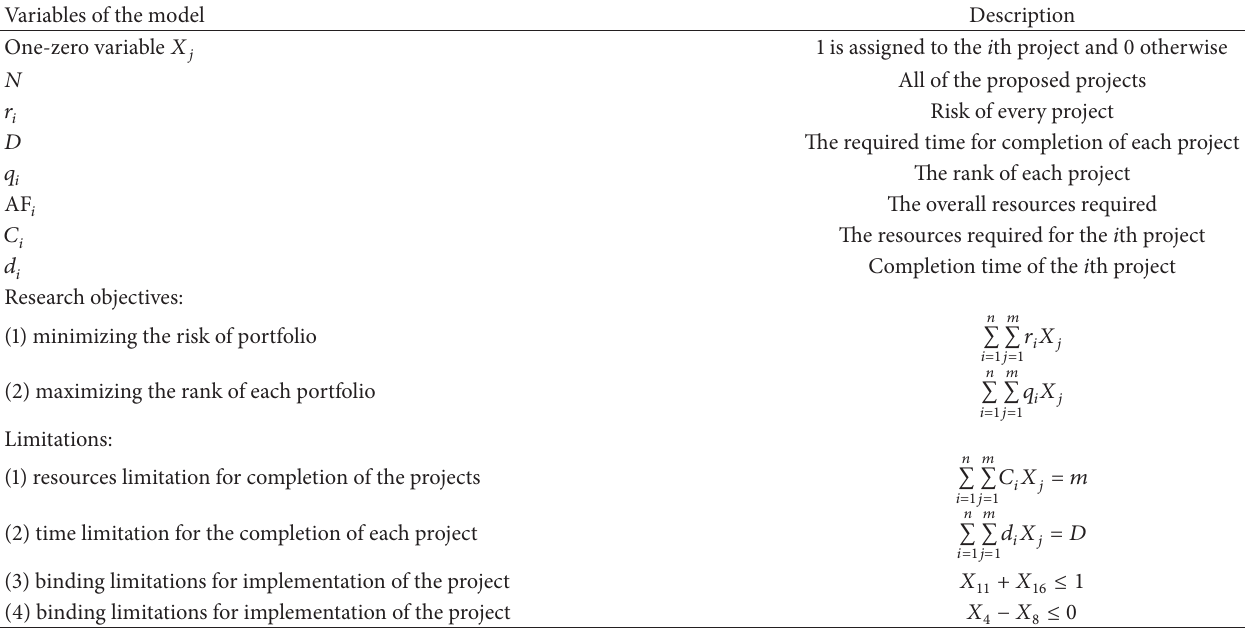
Table 3: The variables and parameters of the mathematical model of project portfolio selection.